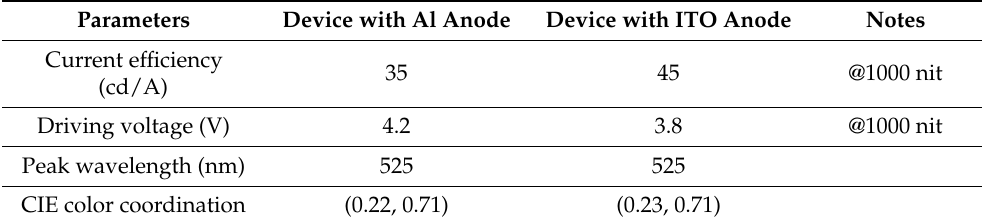
Table 1. Measured characteristics of green top emitting OLED devices with Al anode and ITO